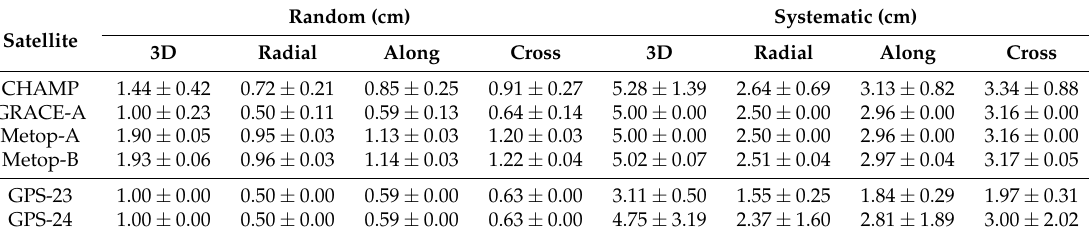
Table 5. Random and systematic position uncertainty estimates (3D) and decomposed with 3D-variance weighting factors w into radial ( w r = 0.25), along-track ( w a = 0.35), and cross-track ( w c = 0.4)